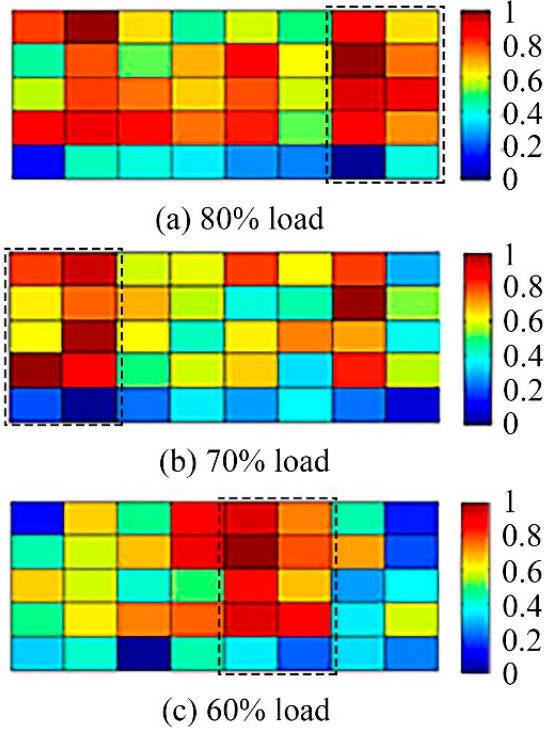
Figure 22. Probability distribution contours of the over-limit load.